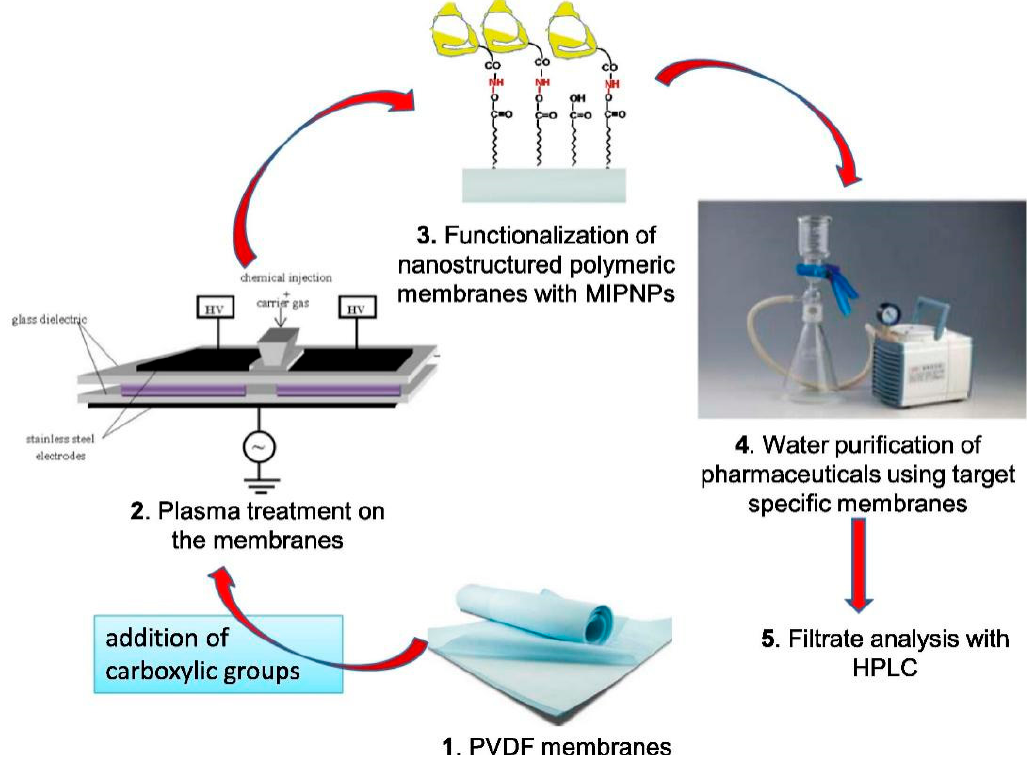
Figure 11. Preparation of functionalized nanostructured MIMs and their application for water purification of pharmaceuticals. Reproduced with permission from